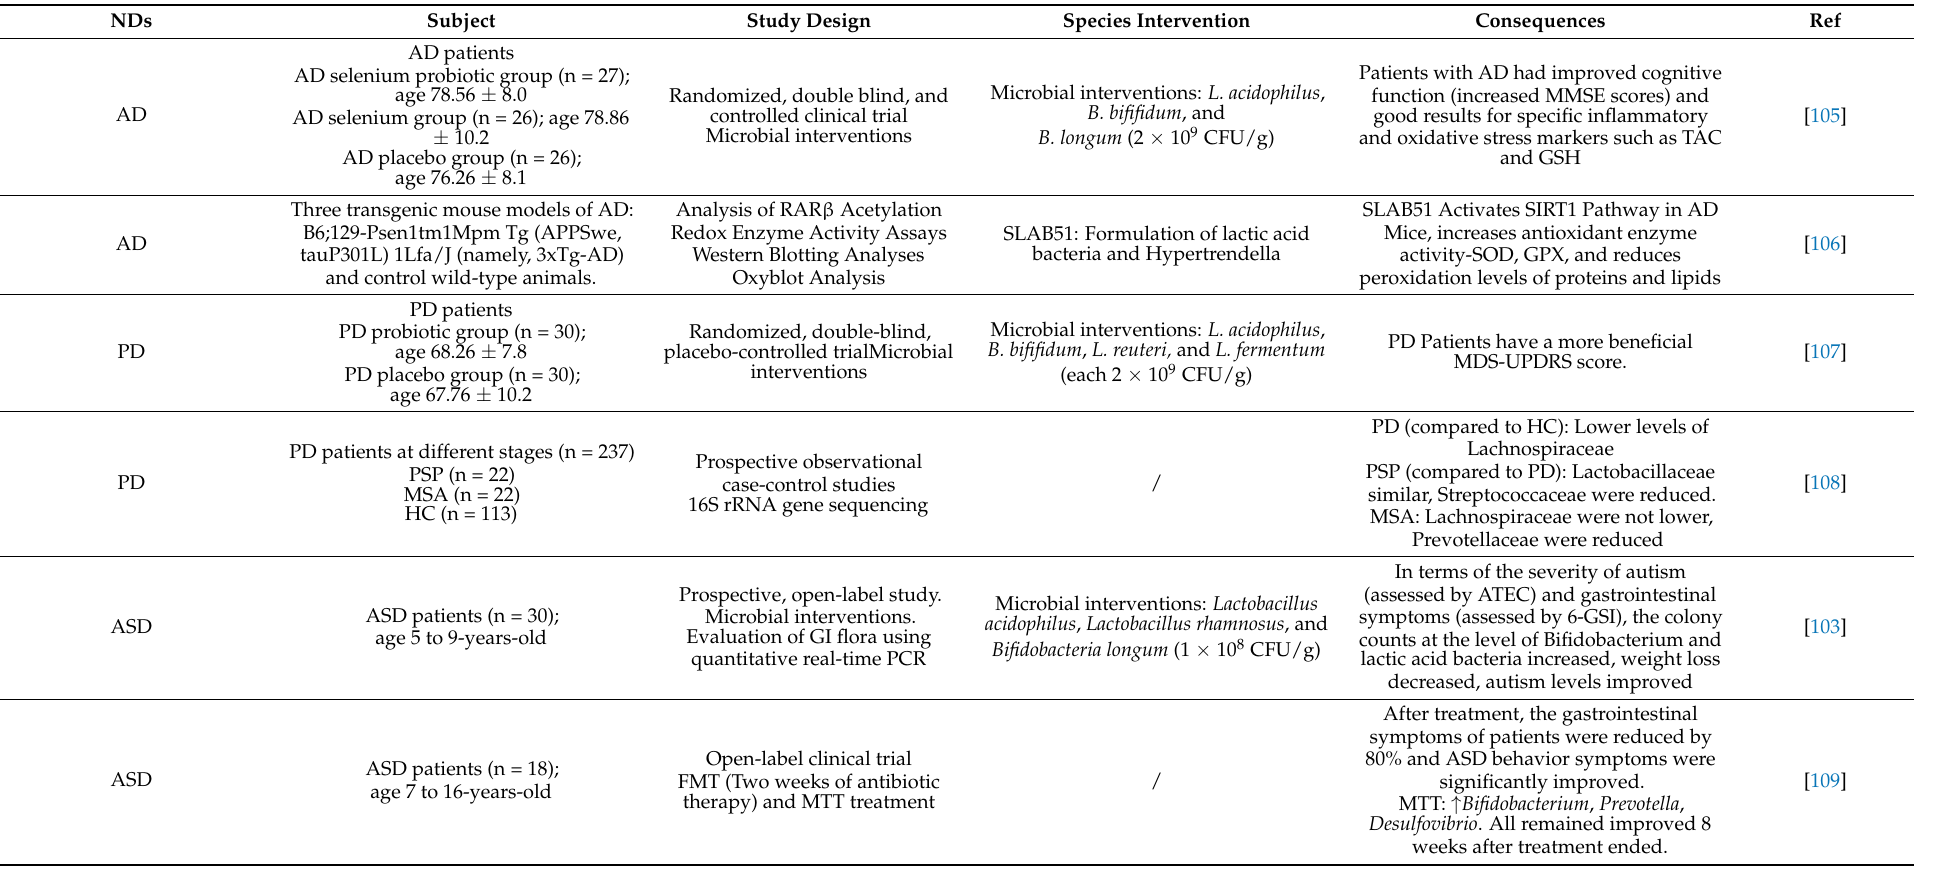
Table 2. Characteristics of prior studies investigating the relation between microbiome and neuropsychiatric